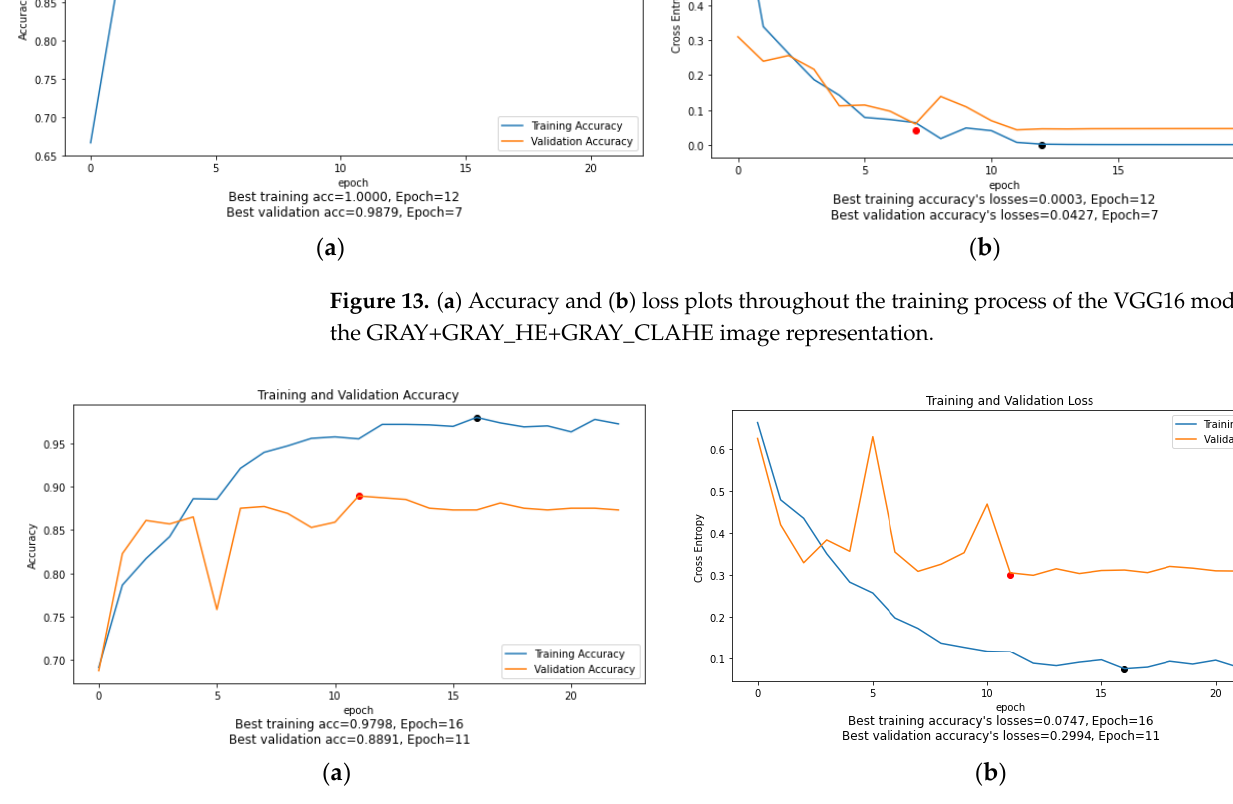
Figure 14. ( a ) Loss and ( b ) loss plots throughout the training process of the ViT-B16 model using the GRAY+GRAY_HE+GRAY_CLAHE image representation.